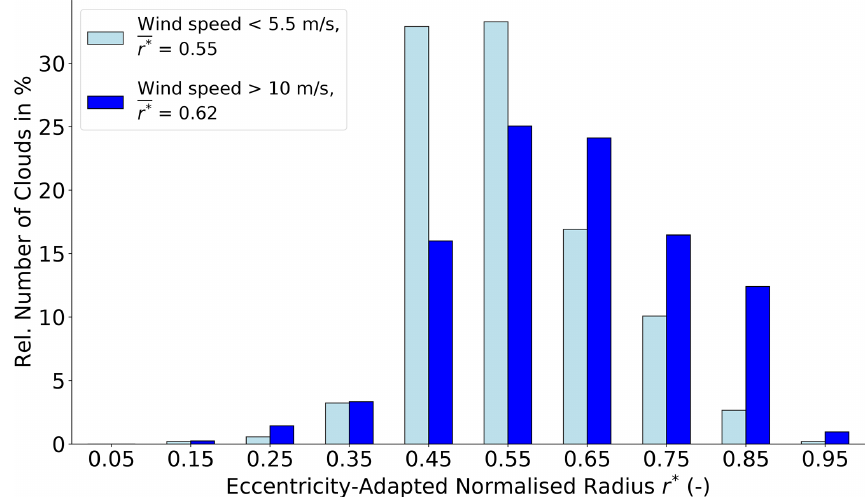
Figure 13. Effective orientation of shallow low-level clouds (CTH < 3000m) from RF03 and RF06, as described by the eccentricity-adapted normalized radius r ∗ for low wind speeds below 5.5ms − 1 (light blue bars) and high wind speeds above 10ms − 1 (dark blue bars) in CTH. Further specifications are given in the